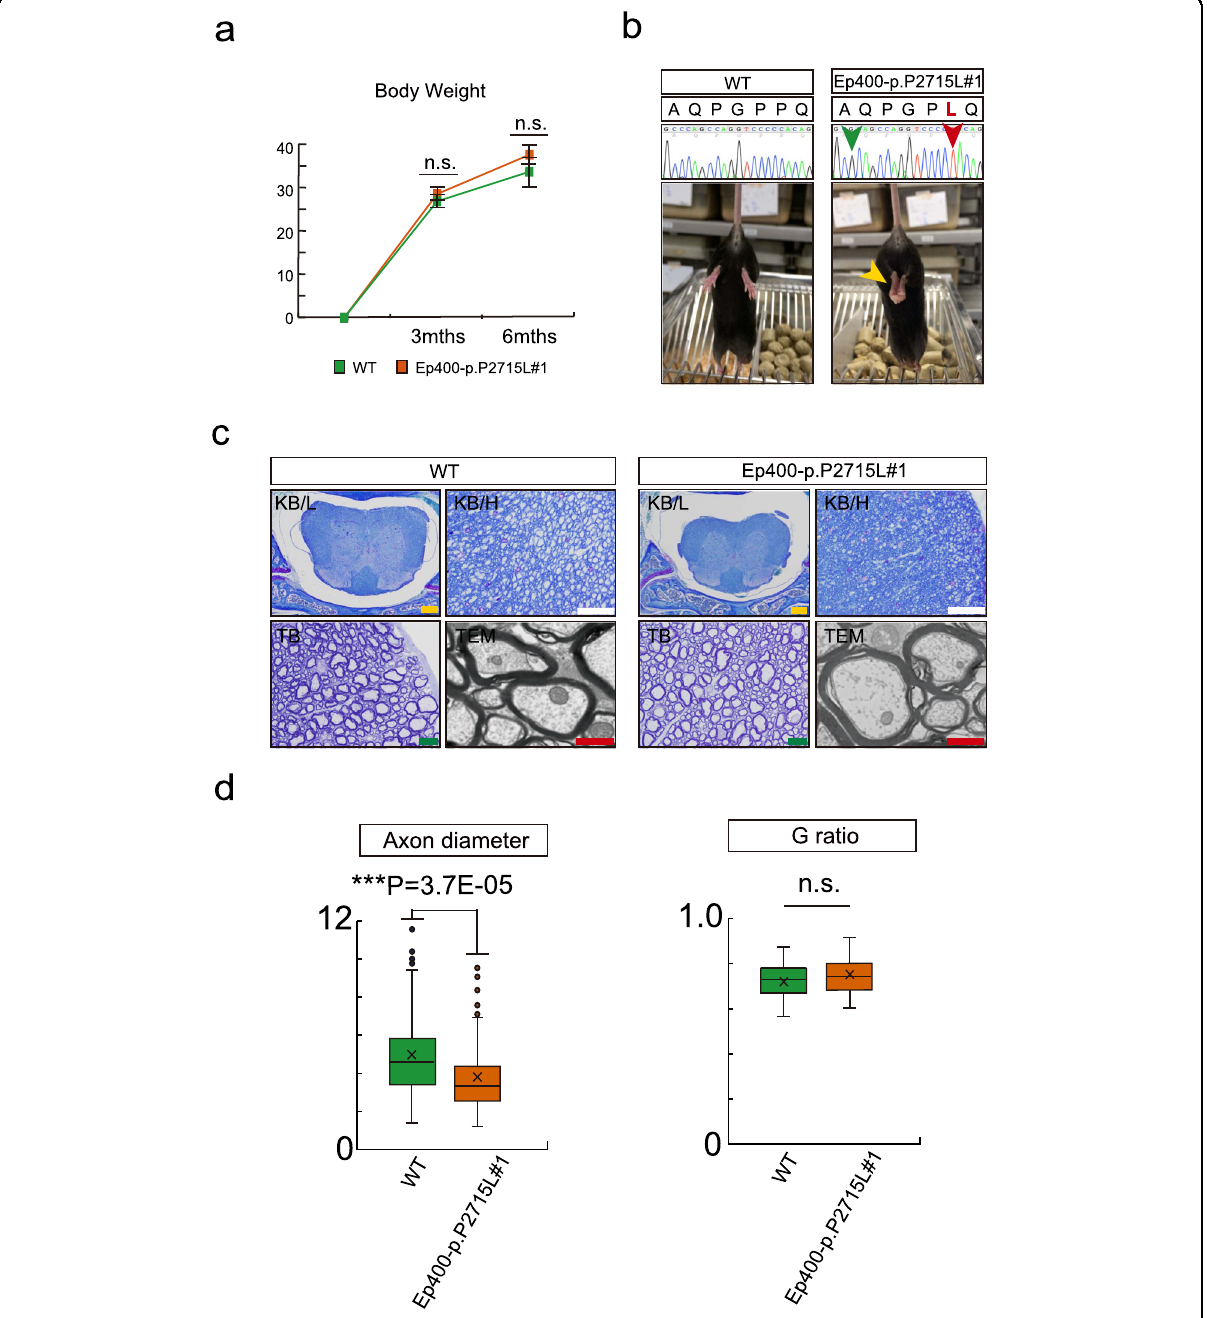
Fig. 2 Screening analysis of known phenotypes in Ep400-p.P2715L mice. a Body weight of Ep400-p.P2715L#1 mice and their WT littermates (p. P2715L#1 mice: n = 6, WT: n = 6). There was no signi fi cant difference in body weight in adult mice. b Genotype and hindlimb clasping. Sanger sequencing was used to con fi rm the missense mutation (p.P2715L, red arrow) and synonymous mutation to break the protospacer adjacent motif ( PAM ; green arrow) in Ep400 . Hindlimb clasping (yellow arrow) was used as a marker of CNS dysfunction (p.P2715L#1 mice: n = 6, WT: n = 6). c In a low-power fi eld, there was no obvious differences in KB-stained tissue between 3-month-old Ep400-p.P2715L#1 mice and their WT littermates. Ep400-p.P2715L#1 mice showed a decrease in axon diameters in the spinal marrow by both KB and TB staining in a high-power fi eld. Ep400-p. P2715L#1 mice did not show any morphological abnormalities in myelin sheaths in the TEM analysis (p.P2715L#1 mice: n = 2, WT: n = 2). KB/L = Klüver – Barrera staining, in a low-power fi eld. KB/H = Klüver – Barrera staining, in a high-power fi eld. TB = Toluidine blue staining. Yellow scale bar = 200 µm. White scale bar = 50 µm. Green scale bar = 10 µm. Red scale bar = 1 µm. d TEM analysis was used to compare axon diameters and G-ratios between Ep400-p.P2715L#1 and WT mice. A signi fi cant decrease in axon diameter in Ep400-p.P2715L#1 mice was con fi rmed by TEM analysis. Ep400- p.P2715L#1 mice did not show signi fi cant differences in G-ratios compared with their WT littermates (p.P2715L#1 mice: n = 2, WT: n =